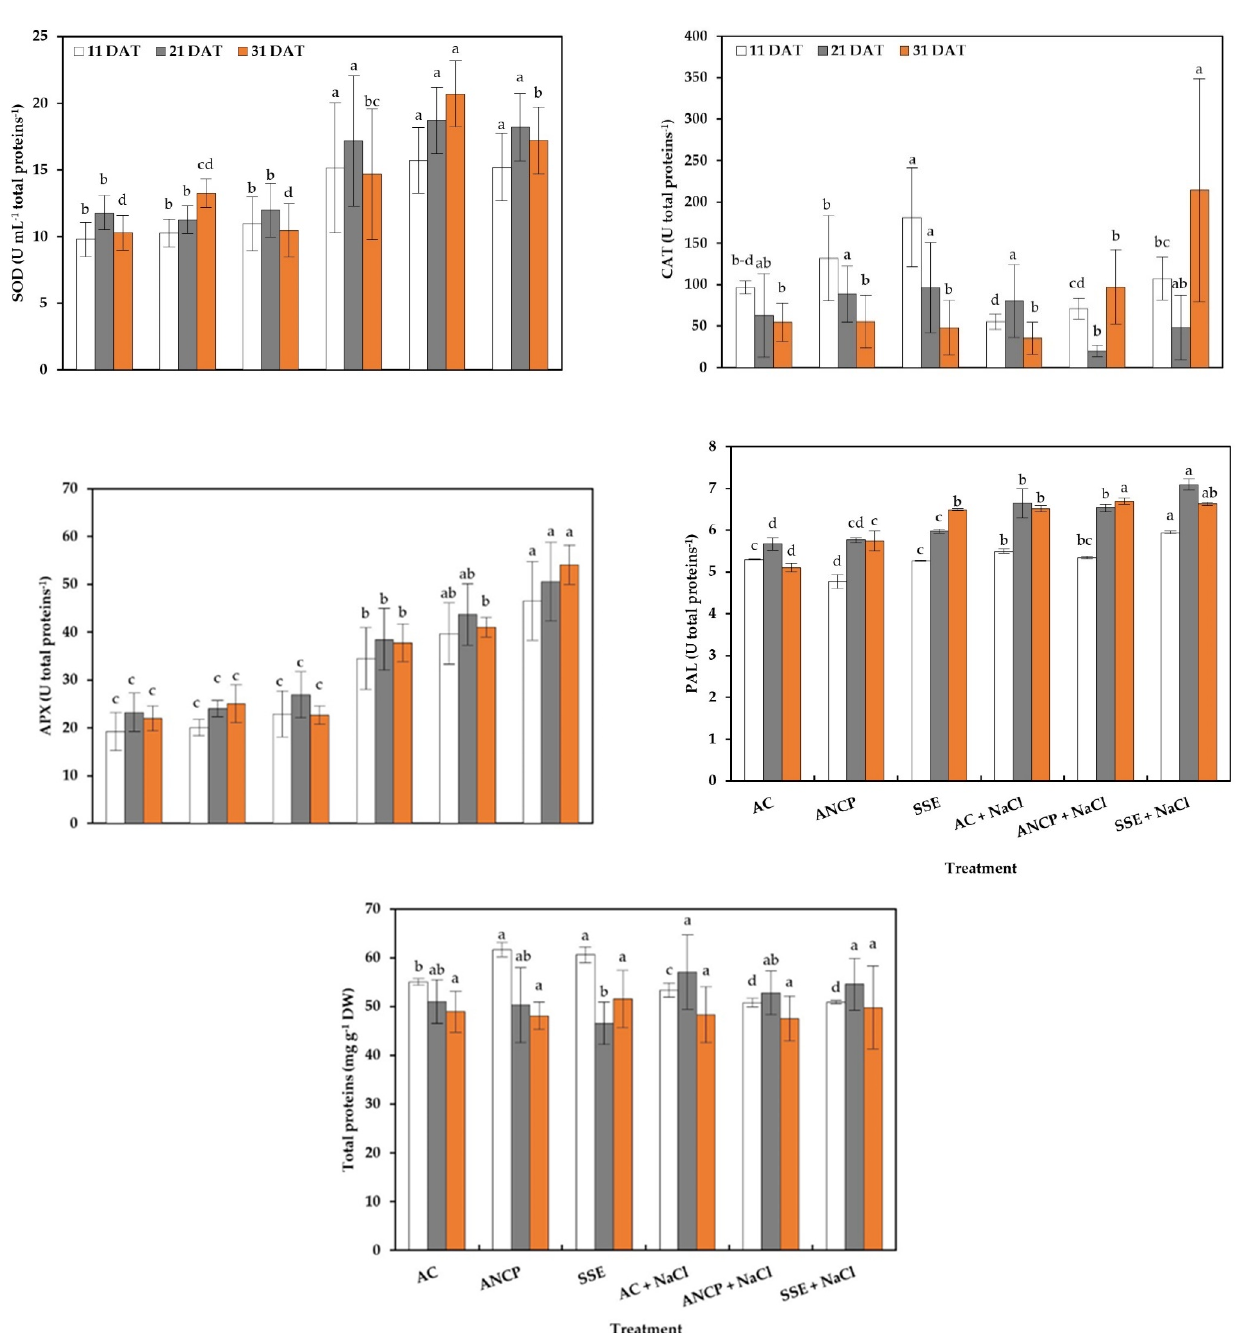
Figure 4. Enzymatic activity and total proteins in the leaves of tomato seedlings. Different letters within each column indicate significant differences between treatments (LSD, p ≤ 0.05). DAT: Days